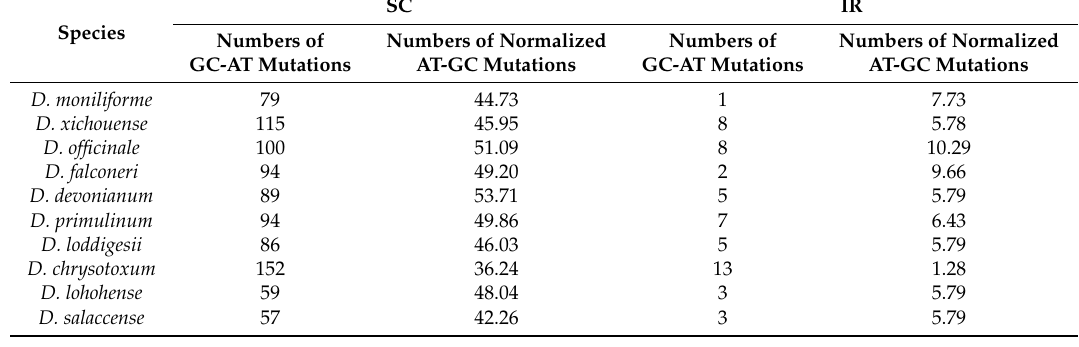
Table 3. Summary of mutations in protein-coding loci.